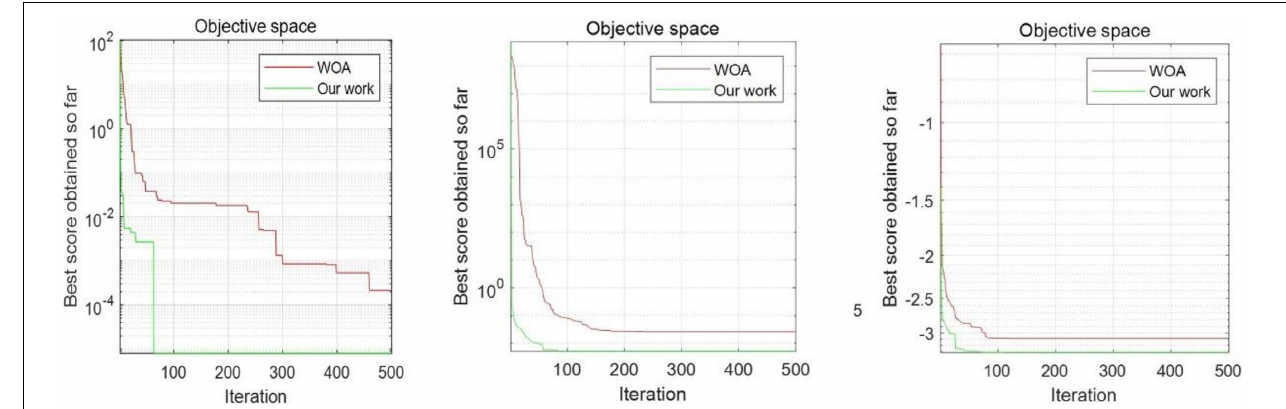
FIGURE 5 | Test functions of functions F7, F12, and